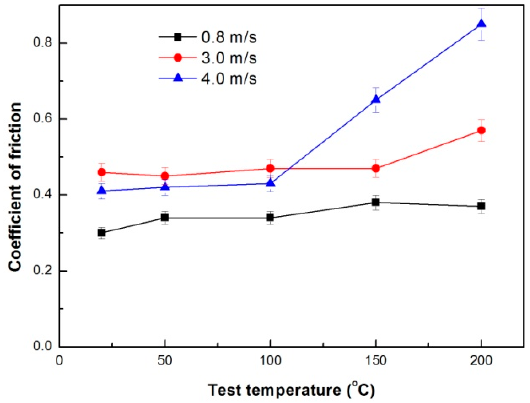
Figure 10. Variations in coefficients of friction at mild–severe wear transition loads with test temperature under different sliding speeds.